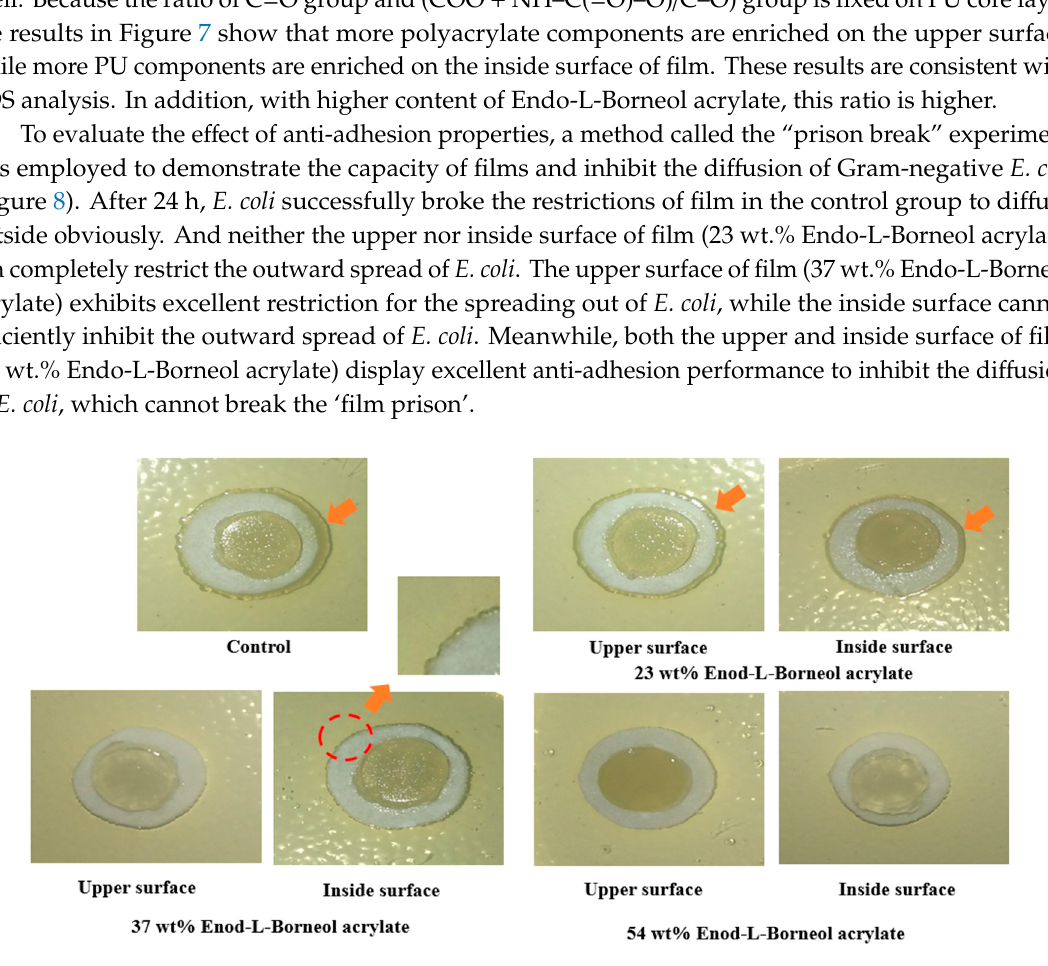
Figure 8. Photographs of modified ‘prison break’ experiments for antibacterial adhesion assays of the films.